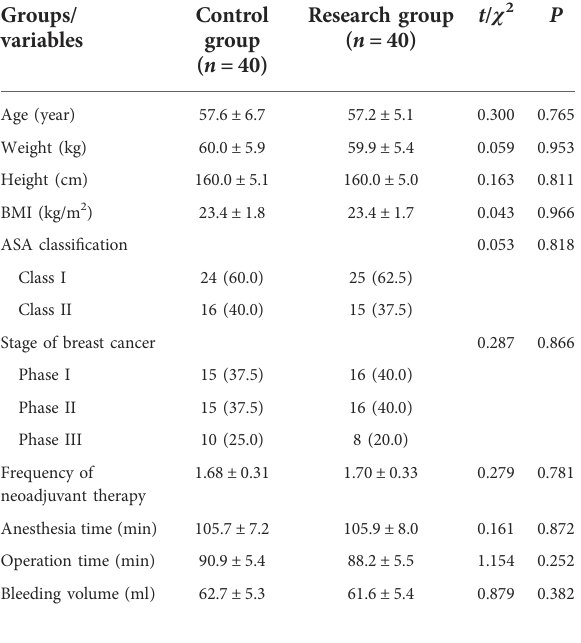
TABLE 1 Comparison of demographic and surgical indicators between two group (mean±SD,